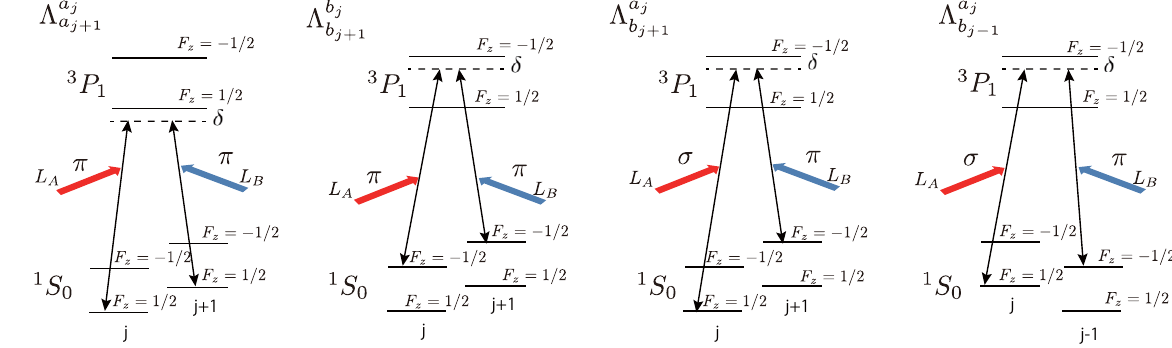
Figure 3. Schematics of four types of laser-assisted hopping in the 171 Yb atom system. The energy difference between the NN sites ( j and j ± 1), and that between F z = 1/2 and F z = − 1/2 in the S 01 manifold at the same site are ±Δ t and Δ ab , respectively. The detunings for the excited states take the same value δ .